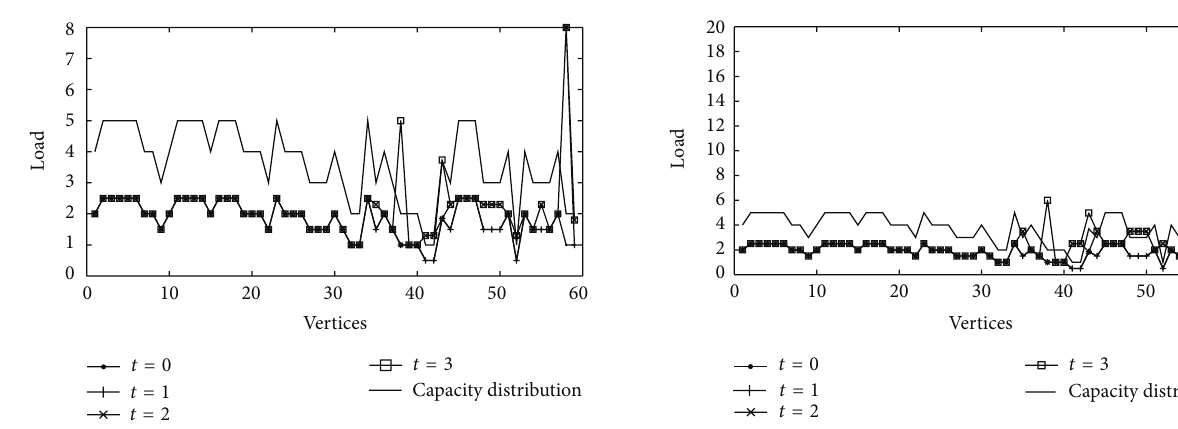
Figure 5: Load distributions of the evolution process in Case I(1).